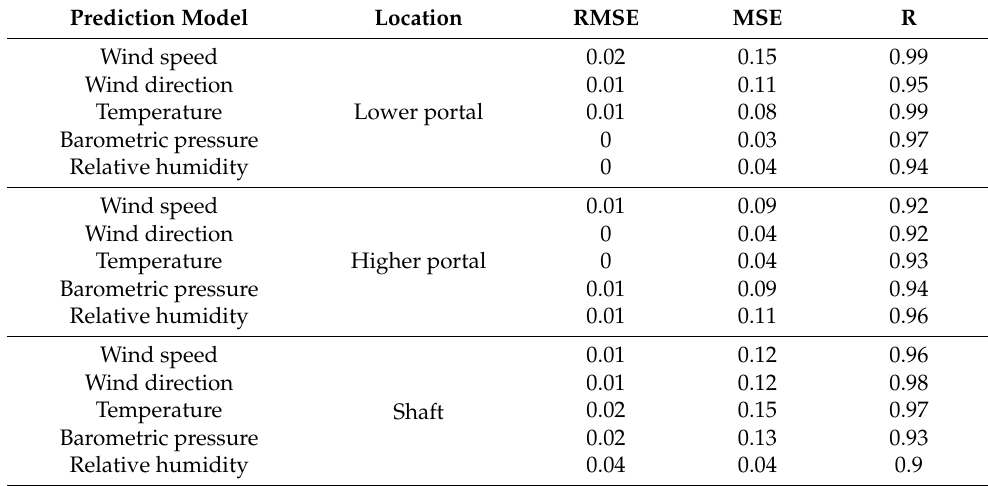
Table 6. Error of each